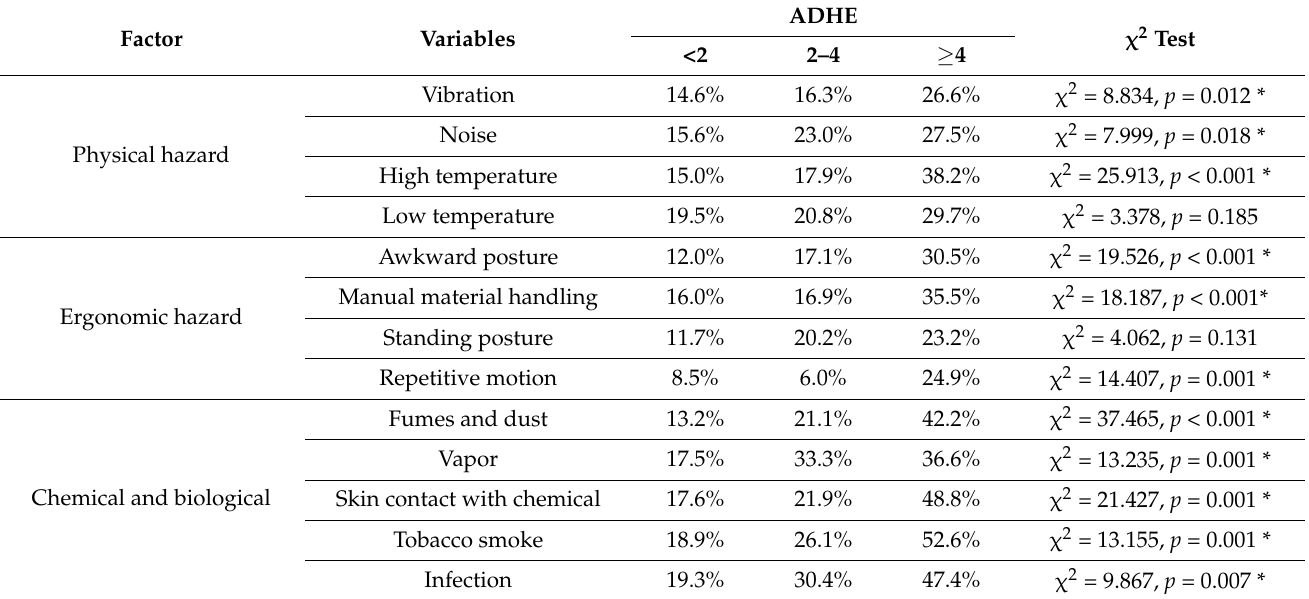
Table 6. Distribution of subjective overall fatigue by the degree of hazard